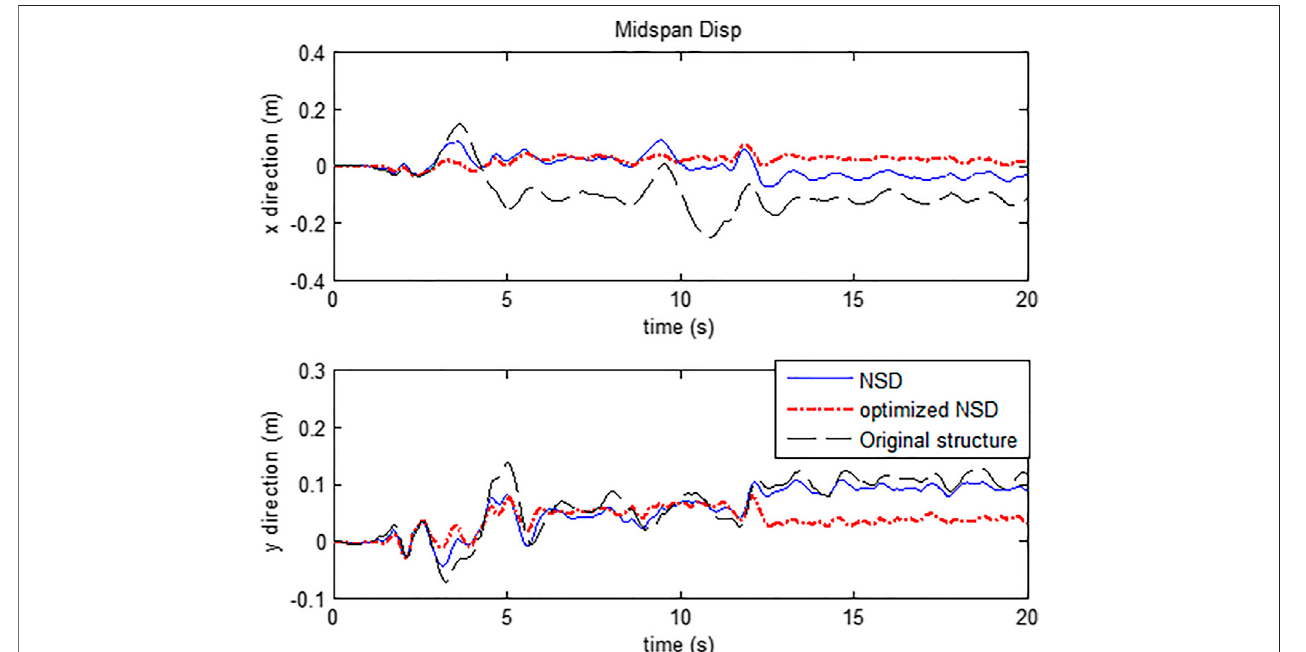
FIGURE 4 | Time history of displacement responses at mid-span under El Centro earthquake.